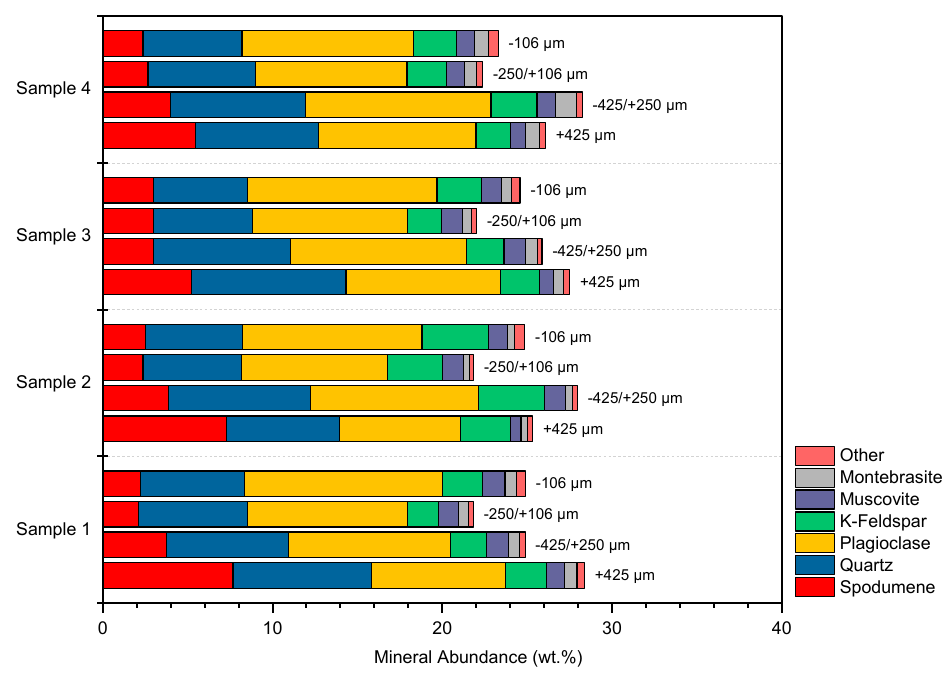
Figure 3. Mineral abundance (wt. %) by size fraction.